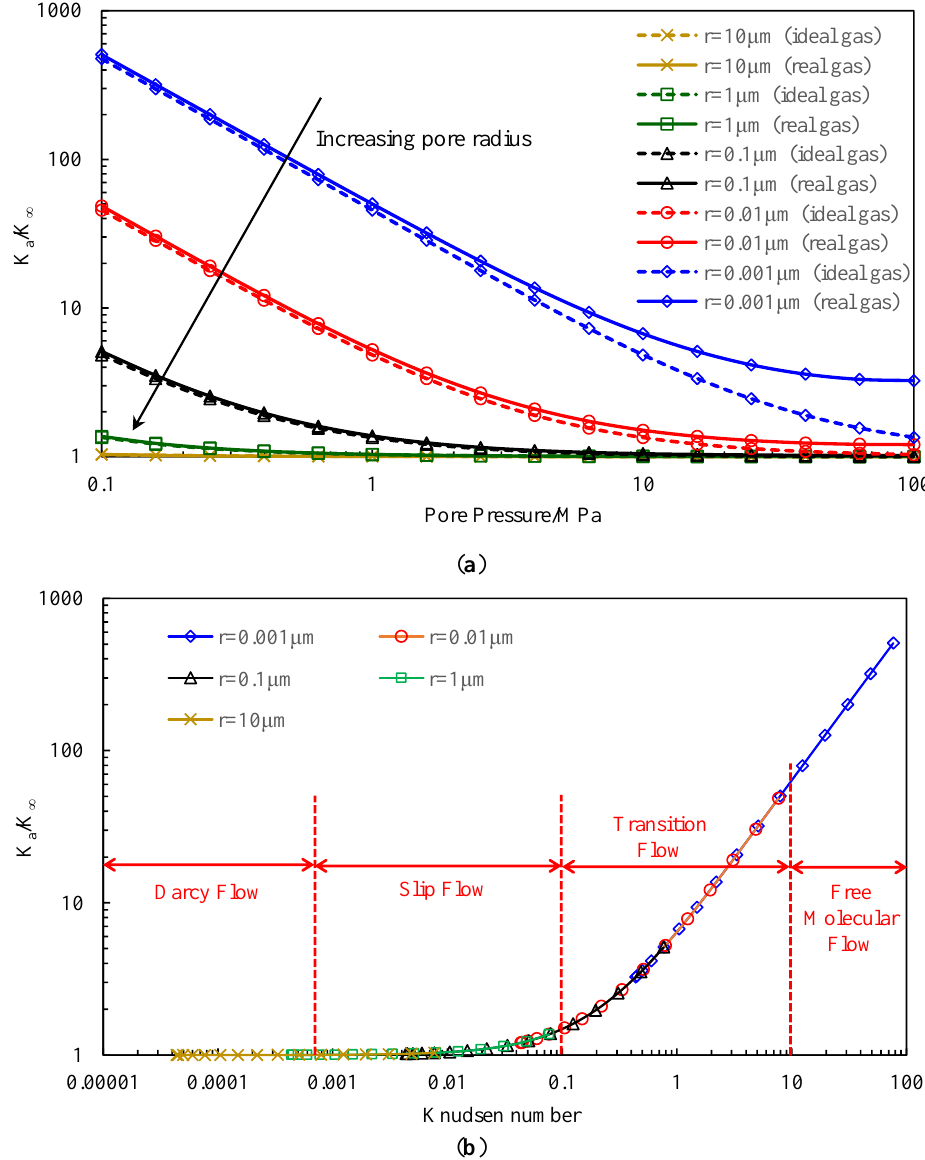
Figure 4. Permeability correction factor for methane at different pore radii. ( a ) Permeability correction factor versus pressure; ( b ) permeability correction factor versus Knudsen number.